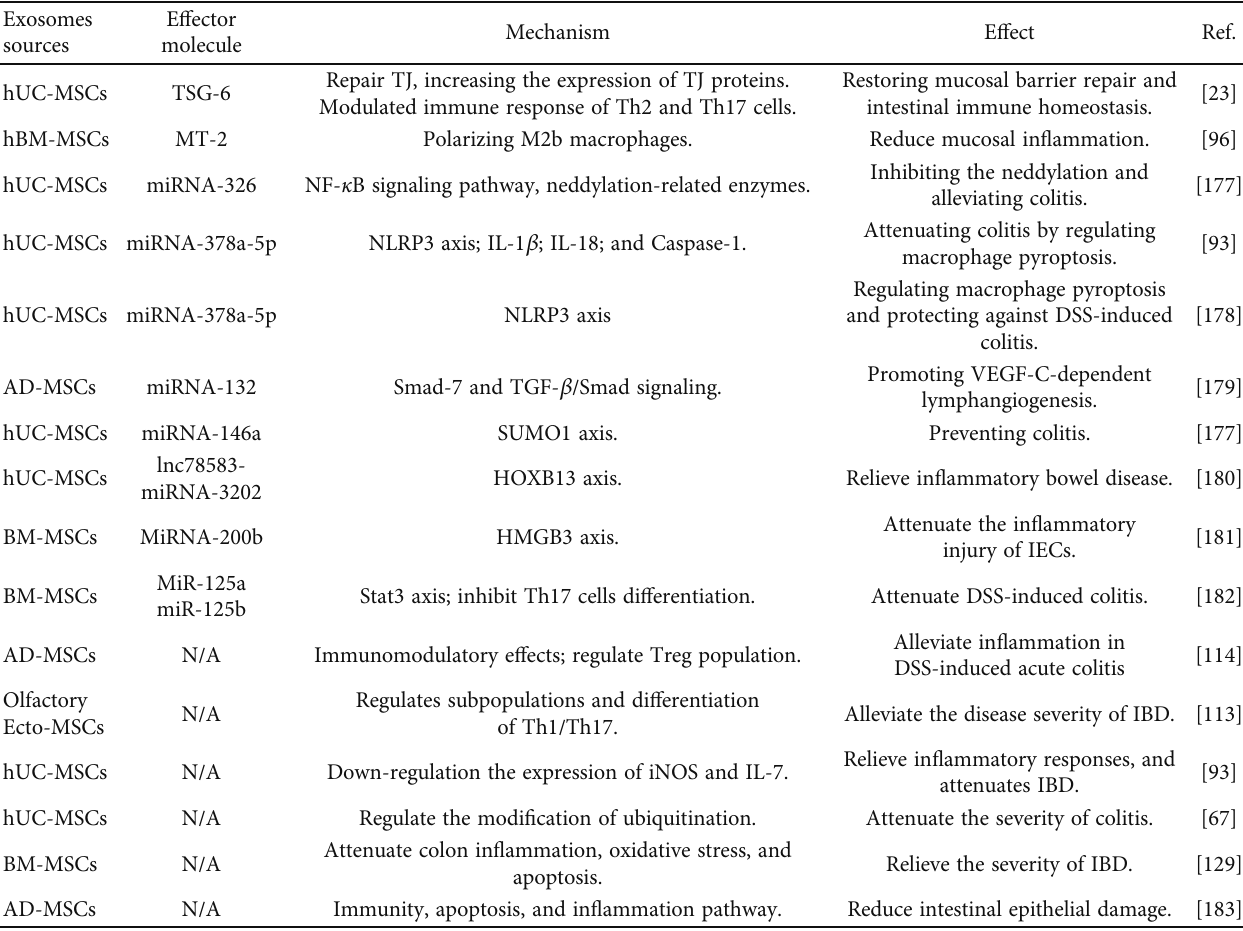
Table 1: Therapeutic application of MSC-Exo in IBD